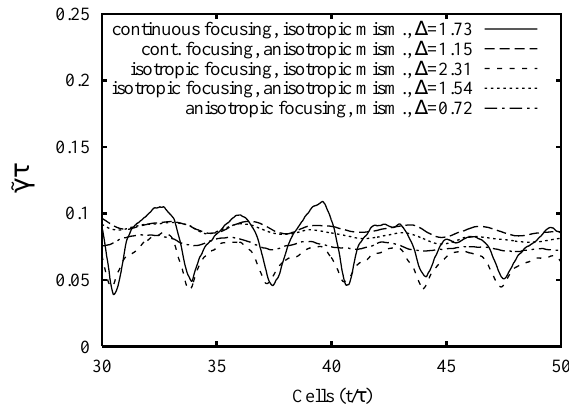
FIG. 7. Normalized friction coefficients ˜ gt for 5000 simula- tion particles versus the number of cells obtained by 3D simu- lations of different focusing systems and matching conditions at s 0 (cid:1) 60 ± , s (cid:1) 15 ± per cell, for a normalized correlation time dt (cid:1) t (cid:1) 0.455 .